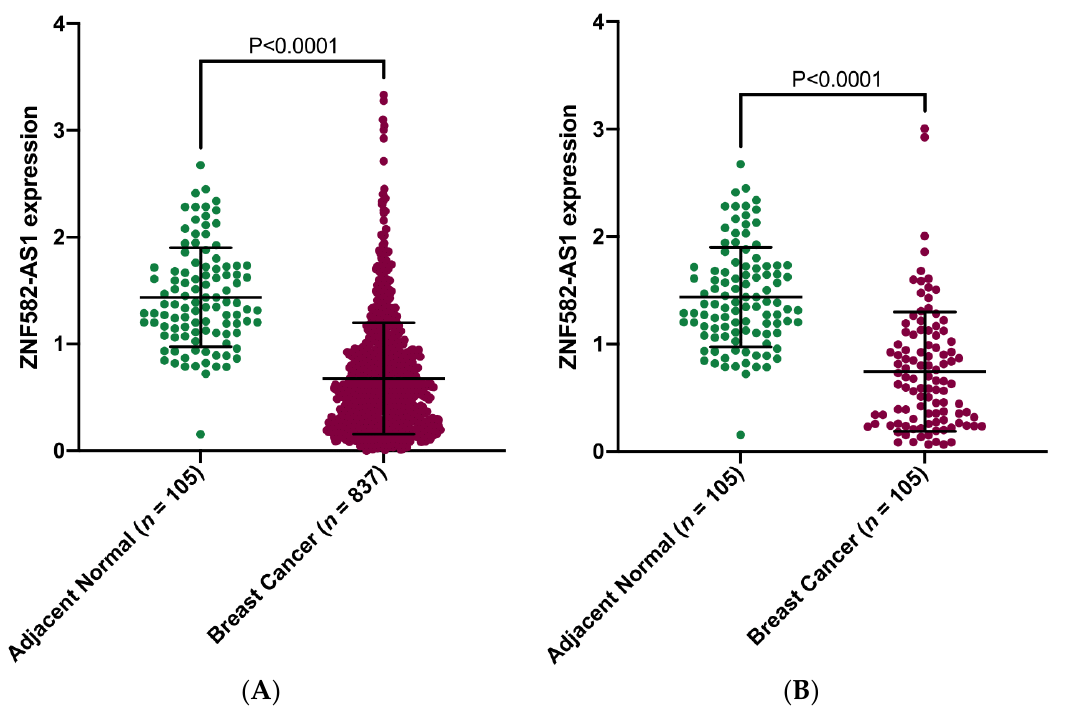
Figure 1. Comparison of ZNF582-AS1 expression between breast cancer and adjacent normal tissues. ( A ) ZNF582-AS1 expression in breast cancer ( n = 837) and adjacent breast tissues ( n = 105). ( B ) ZNF582-AS1 expression in matched breast cancer ( n = 105) and adjacent breast tissues ( n = 105).